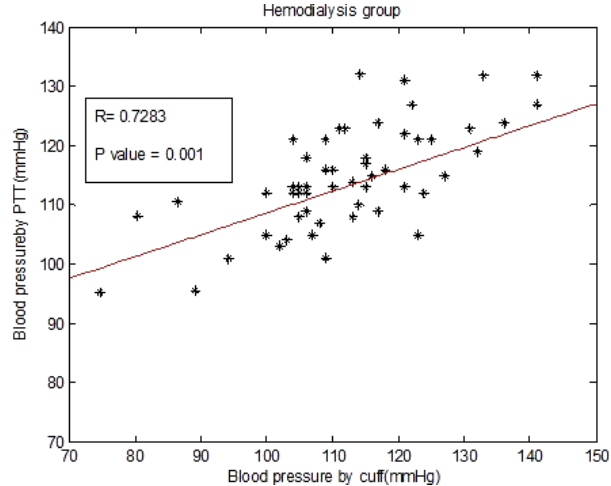
Fig. 7. Plot of systolic BP measured by cu® versus systolic blood pressure calculated from the pulse transit time of the hemodialysis group. The straight line represents linear regres- sion (see inserted R and P value).